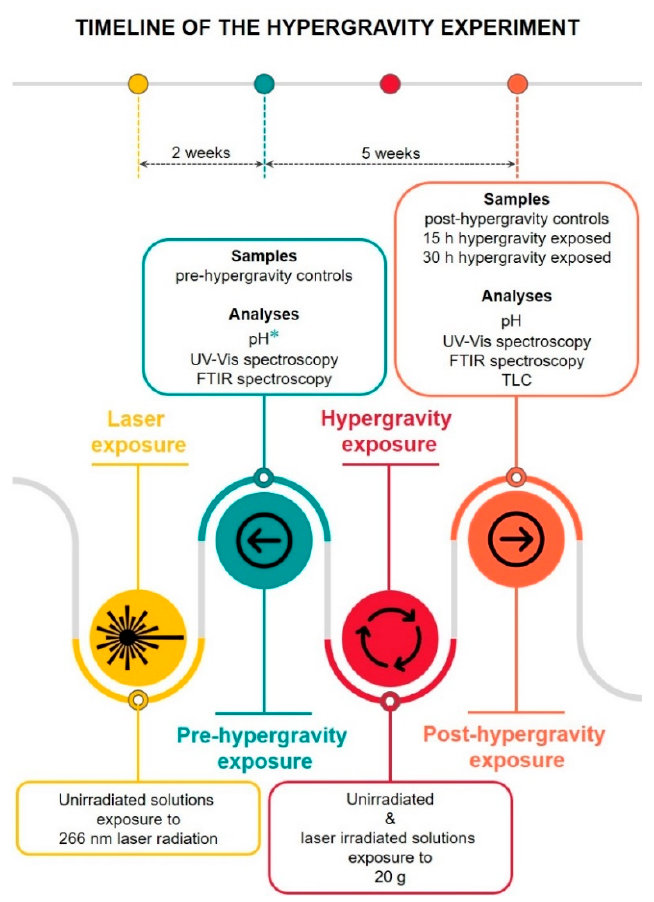
Figure 2. Graphical representation of the hypergravity experiment. The timeline of the study illustrates the various phases together with their associated sets of samples and types of analyses. Each set of samples comprises all combinations of medicine types (PMZ and TZ), concentrations (2 and 20 mg/mL), and irradiation times (1, 15, 30, 60, 120, and 240 min). * Pre-hypergravity pH data obtained immediately after the laser irradiation process. Note bene: controls—unirradiated and laser-irradiated solutions not subjected to hypergravity conditions.